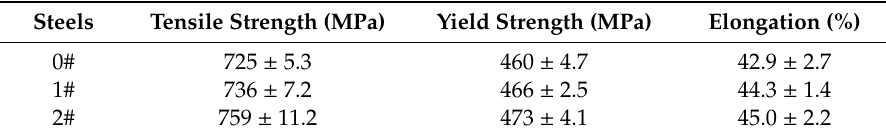
Table 8. Tensile properties of the 0#–2# experimental specimens.